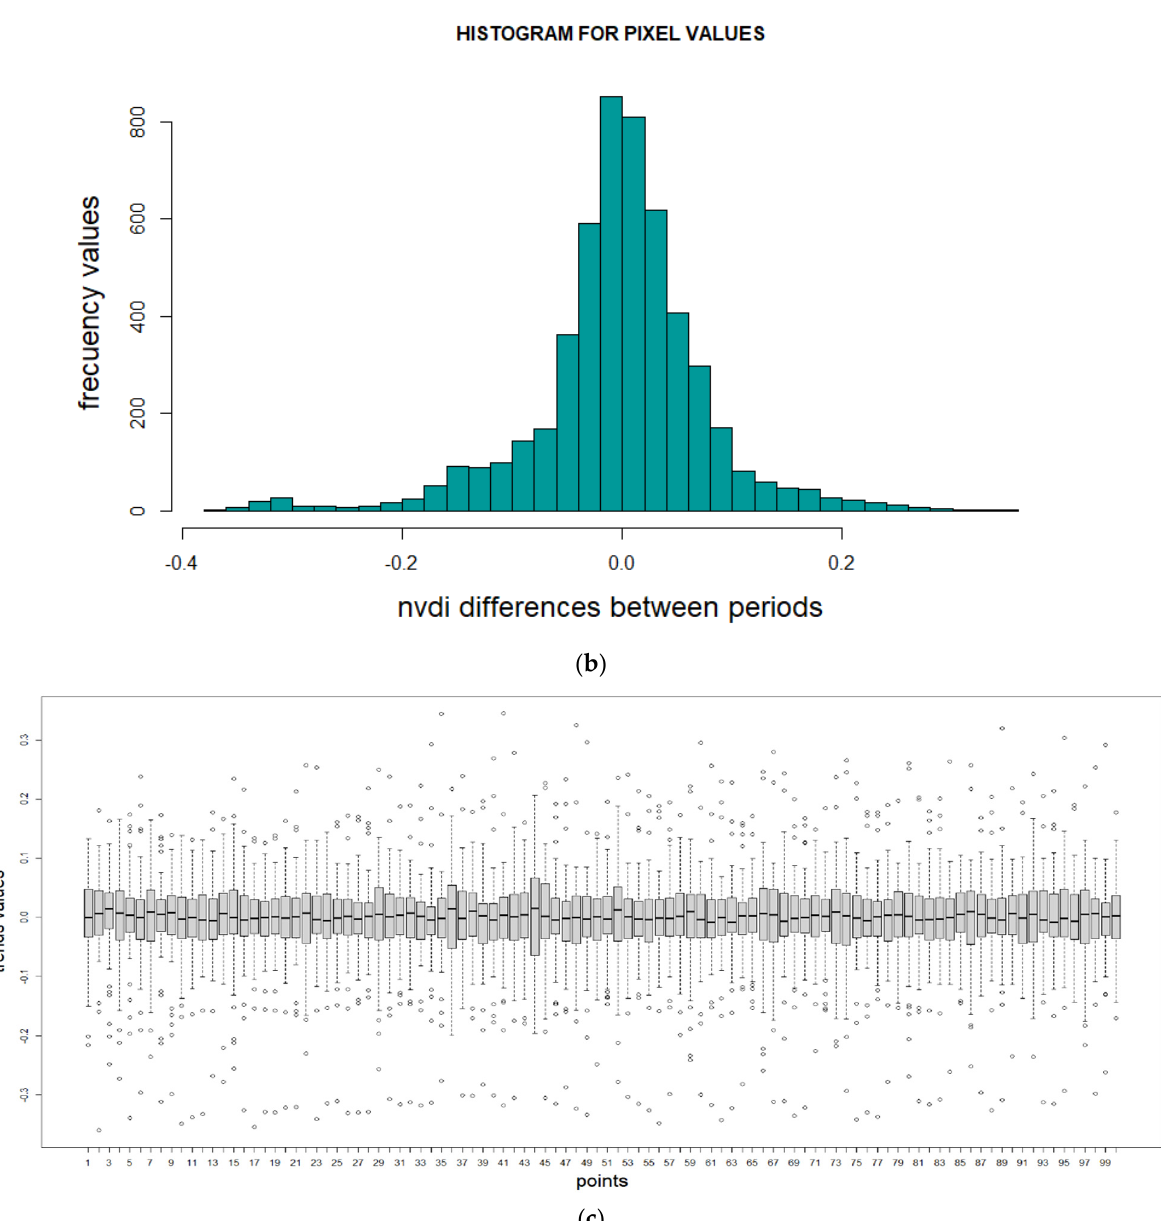
Figure 8. Example plot of Eucalyptus with an area of 0.99 ha. ( a ) Location of the center pixel (100) where the information of the analyzed period (53) was stored. ( b ) Histogram representing the frequency of each of the pixel values along the analyzed time series. ( c ) Boxplot analysis of each pixel found within the plot and variations in their values along the time series.